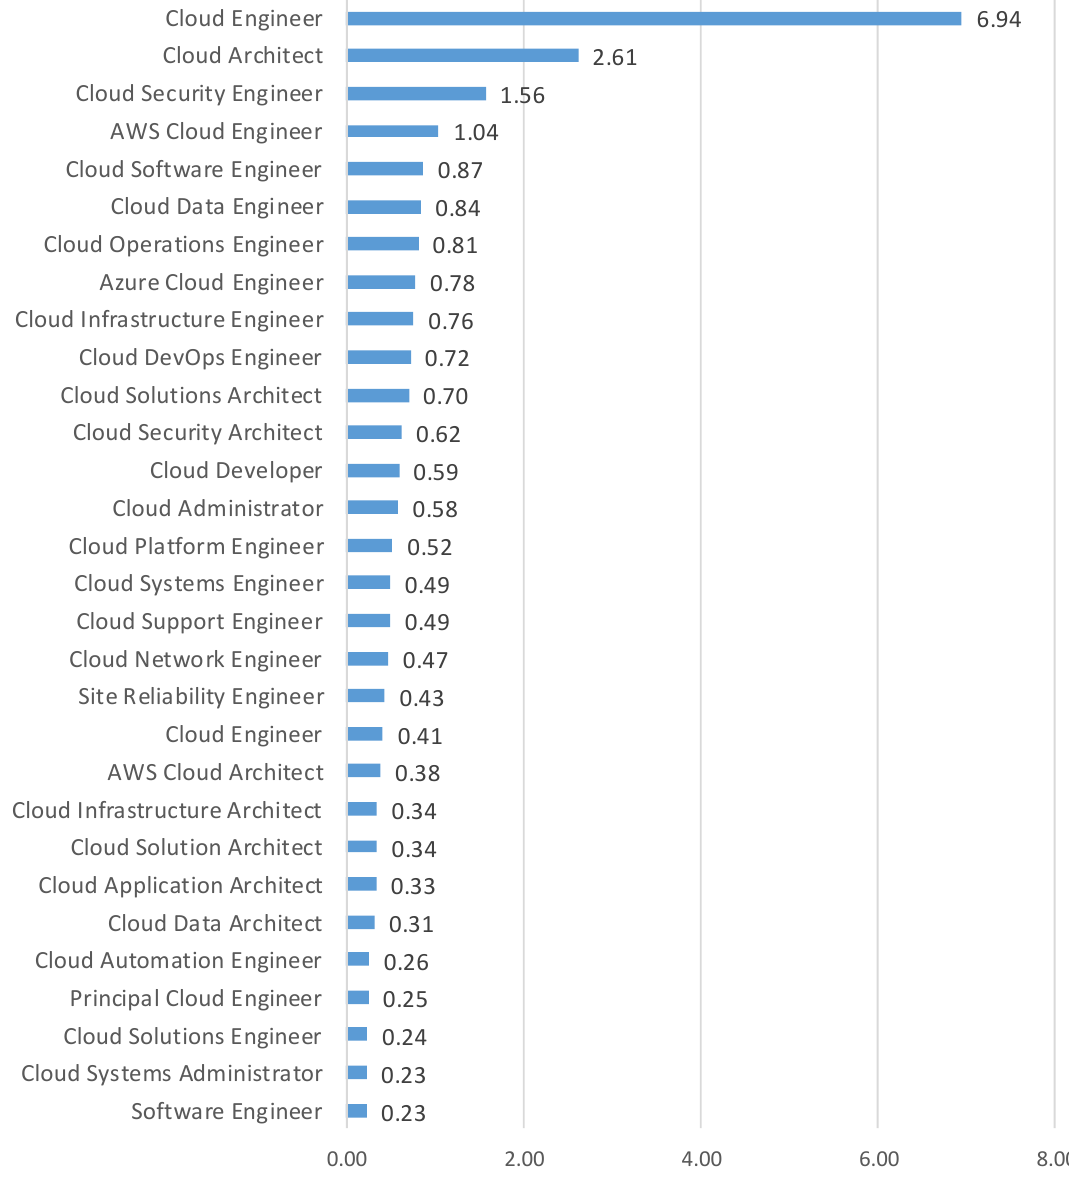
Figure 1. Top 30 job titles and percentages.